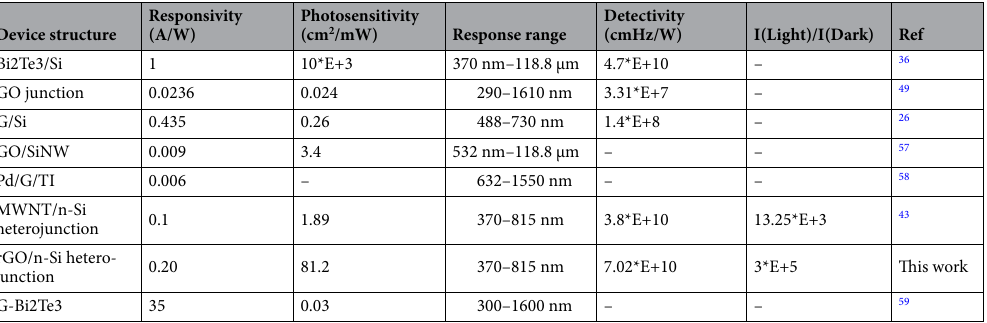
Table 1. Comparison on performances of photodetectors and rGO/n-Si based device. The responsivity of the device reported in the table refers to 685 nm light